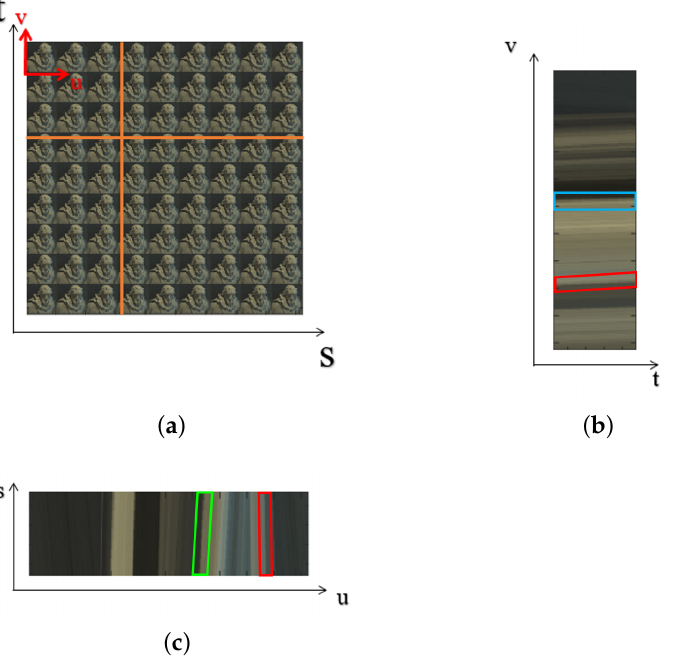
Figure 6. ( a ) The sub-aperture image view; ( b ) the EPI for the vertical line represented in ( a ); ( c ) the EPI for the horizontal line represented in ( a